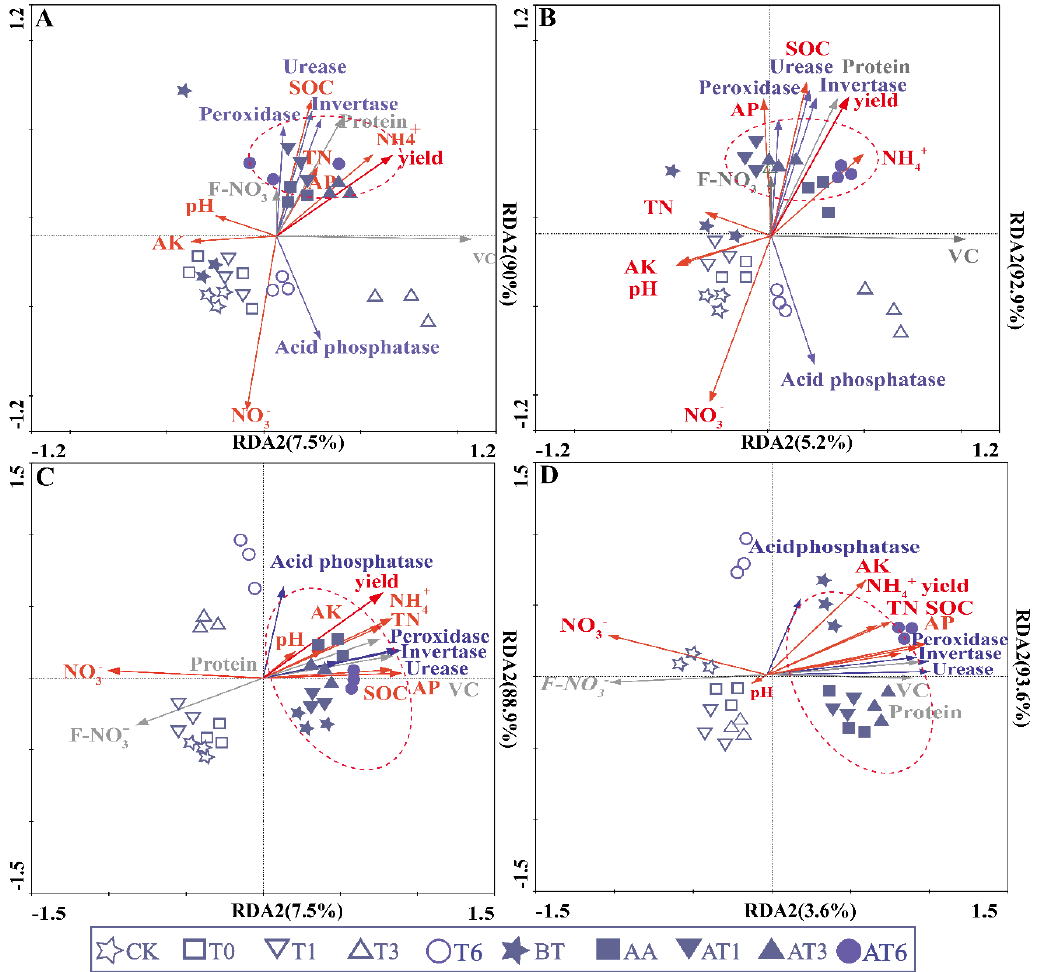
Figure 5. The correlations of different parameters, including soil physicochemical properties, soil enzyme activities and yields. SOC means soil organic carbon; TN means total nitrogen; AP means available phosphorus; AK means available potassium; F-NO 3− means content of NO 3− in fruit.